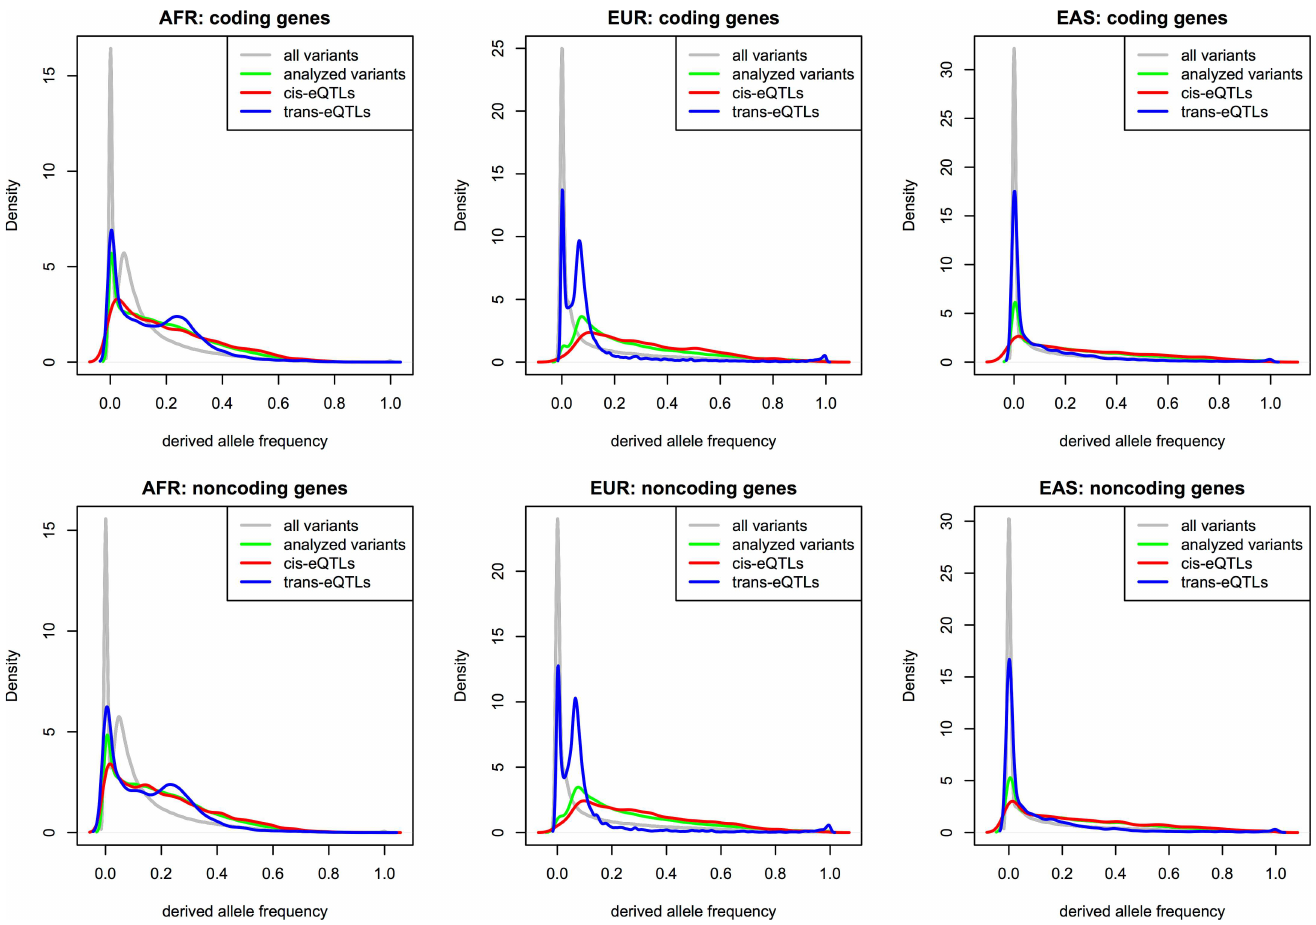
Fig 6. Distributions of DAFs of all variants, analyzed variants, cis-eQTLs, and trans-eQTLs in gene regions.